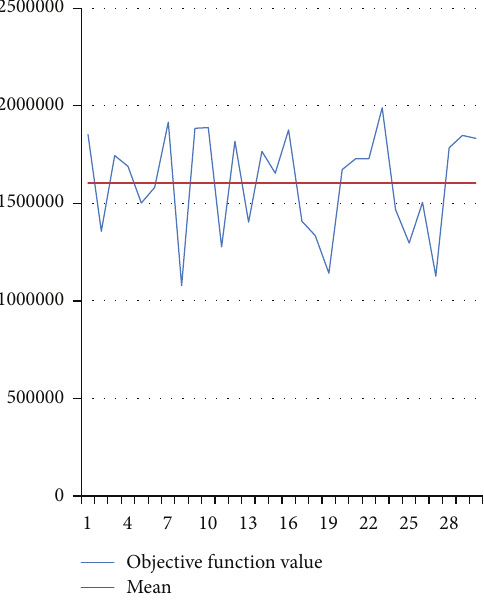
Figure 4: The fluctuation curve of optimal objective function value by HGSAA.